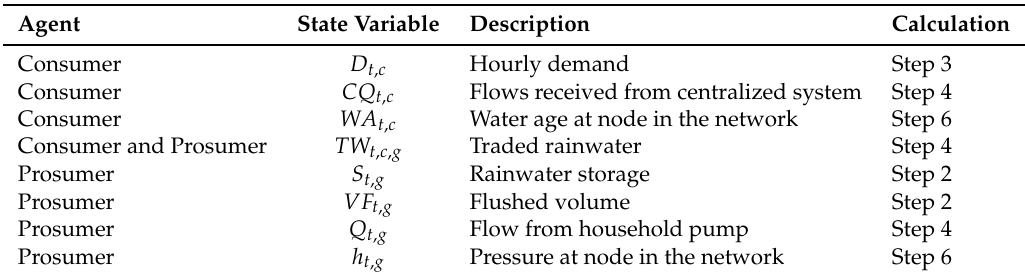
Table 2. State variables for consumer and prosumer